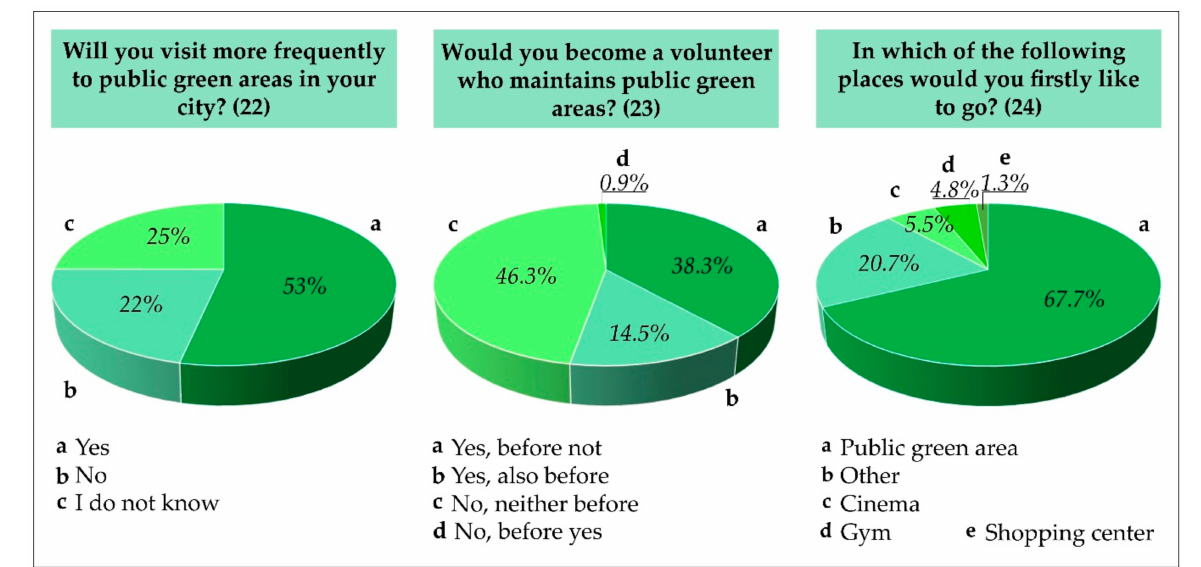
Figure 4. Potential use of green spaces and change of habits after the social distancing period (questions 22, 23, and 24). Table 4. Chi-square test and correspondence analysis results regarding questions